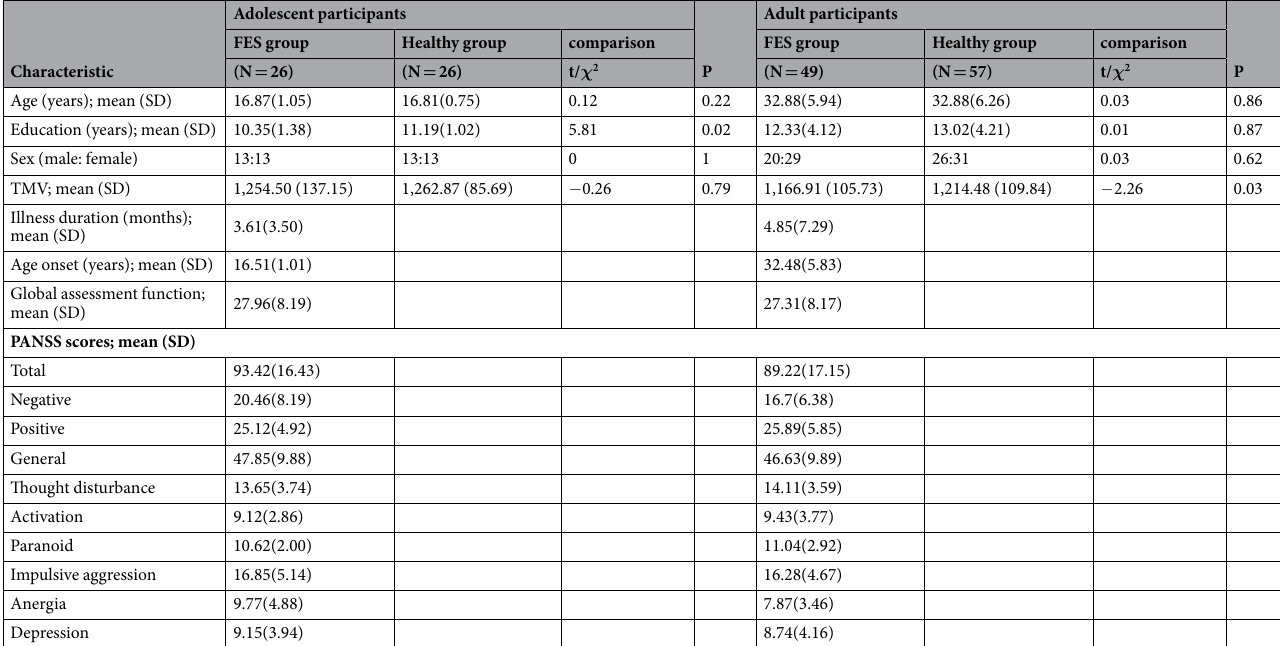
Table 1. Demographic variables and clinical characteristics of adolescent-onset and adult-onset antipsychotic- naïve, first-episode schizophrenia patients and healthy control subjects. Notes: PANSS, Positive and Negative Syndrome Scale; FES, antipsychotic-naive first-episode schizophrenia; TMV, total gray and white matter